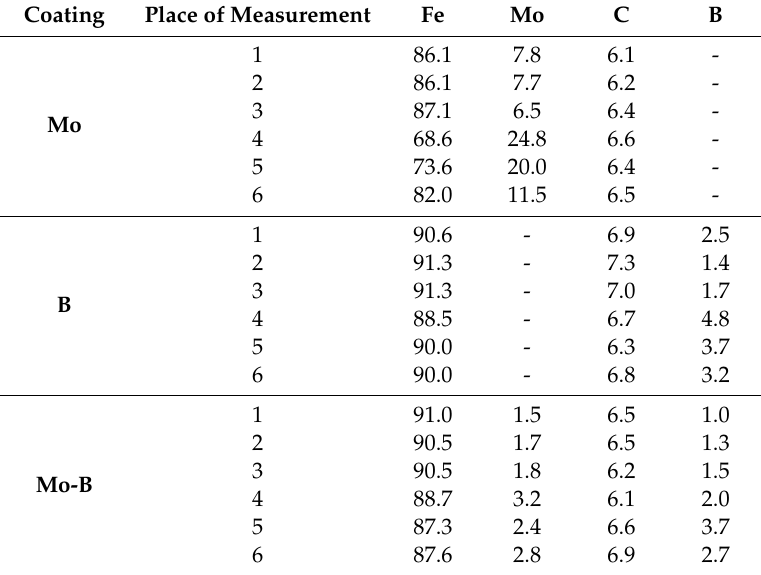
Table 4. Results of EDS point analysis of produced: (a) Mo coating, (b) B coating, (c) Mo-B coating. Coating Place of